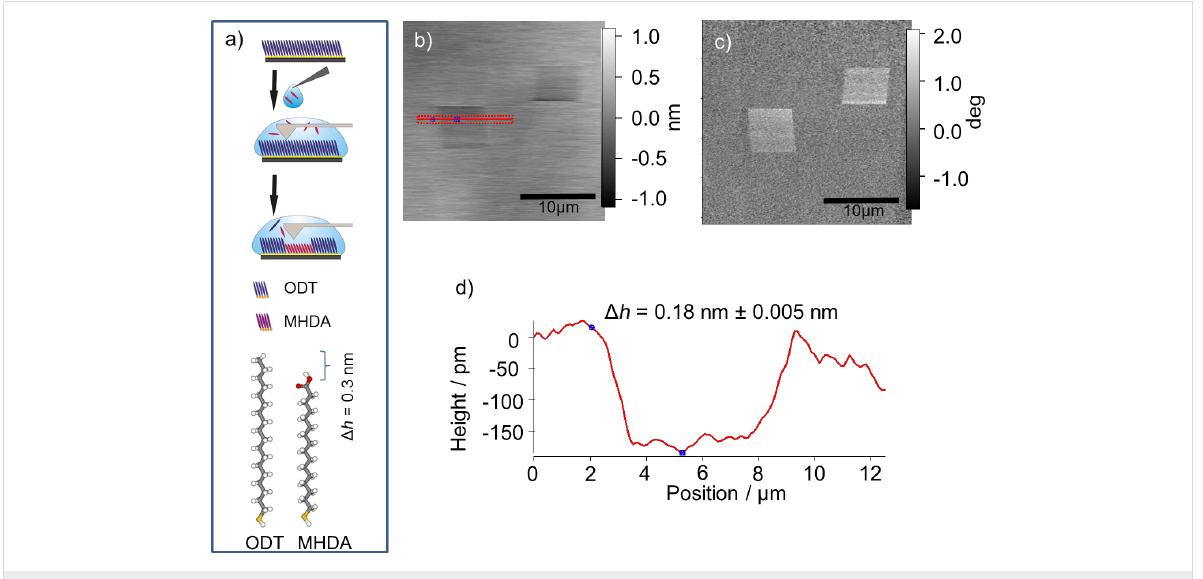
Figure 6: (a) Scheme of the grafting experiment and used SAM molecules. AFM-topography (b) and -phase (c) images of the MHDA areas grafted into an ODT matrix SAM. (d) Cross section along the red line in (b).